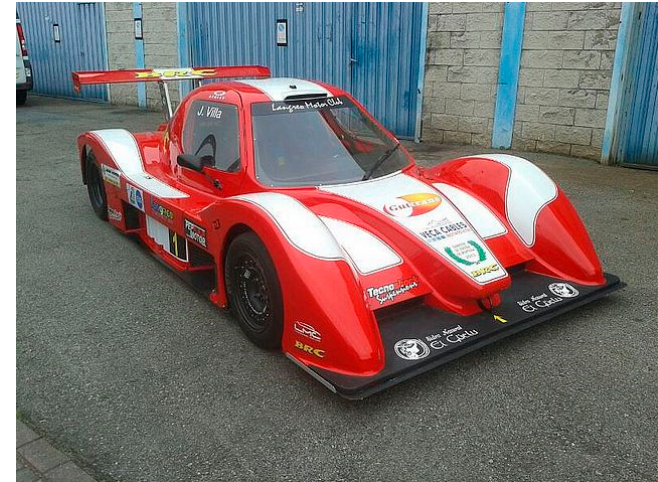
Table 1. Vehicle parameters.